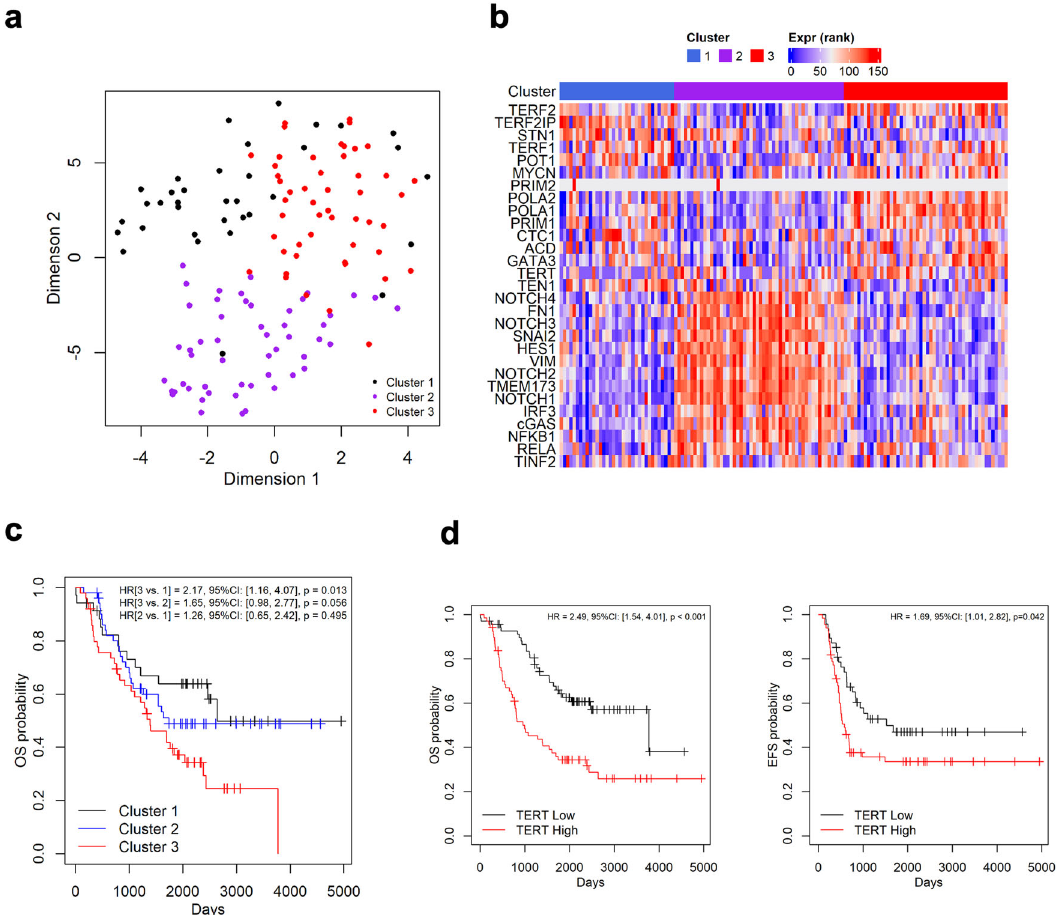
Fig. 6 Analysis of clinical tumor samples using a telomere- and cell lineage-related signature gene list. a The RNA levels (rank transformed) of a list of 29 telomere-, cell lineage- and immunity-related genes across 137 NB tumors with RNA-seq data were analyzed and clustered using PAM and displayed as a t-SNE plot. b The rank transformed RNA levels of signature genes across clustered NB tumor samples are displayed in Heatmap. c Kaplan – Meier overall survival curves for three clusters of patients with distinct gene expression pro fi les. d Kaplan – Meier overall survival and event free survival curves for patients with high TERT and low TERT